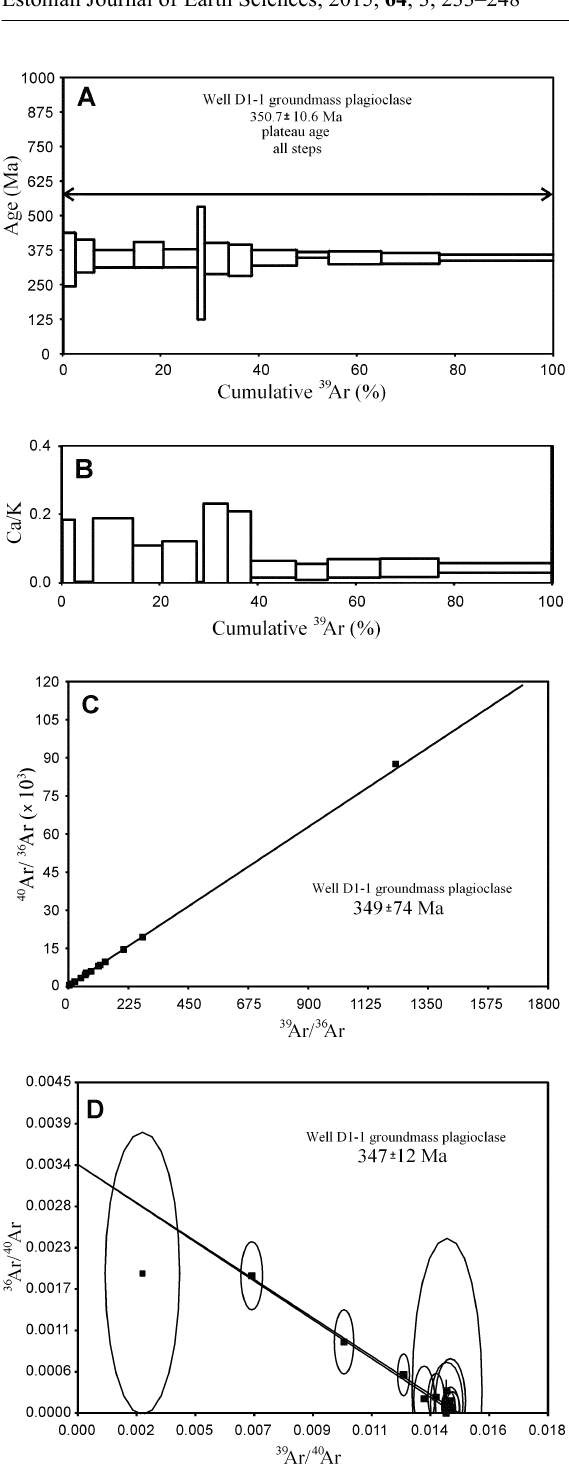
Fig. 5. A , gas release spectrum for groundmass plagioclase from sample D1-1 (VU run 01M0008). The weighted mean age for all 13 steps is 351  11 Ma (2-sigma). B , Ca/K vs released 39 Ar diagram showing a constant Ca/K ratio. C , 349  74 Ma normal isotope correlation age. D , 347 +/– 12 Ma inverse isotope correlation